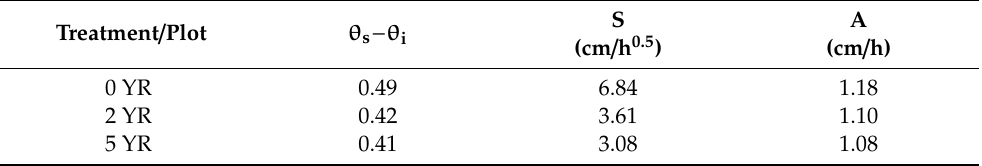
Philip’s model parameters estimated for the three experimental plots of this study. The di ff erence between saturated soil water content, θ s , and initial soil water content, θ i , is also given. Treatment /